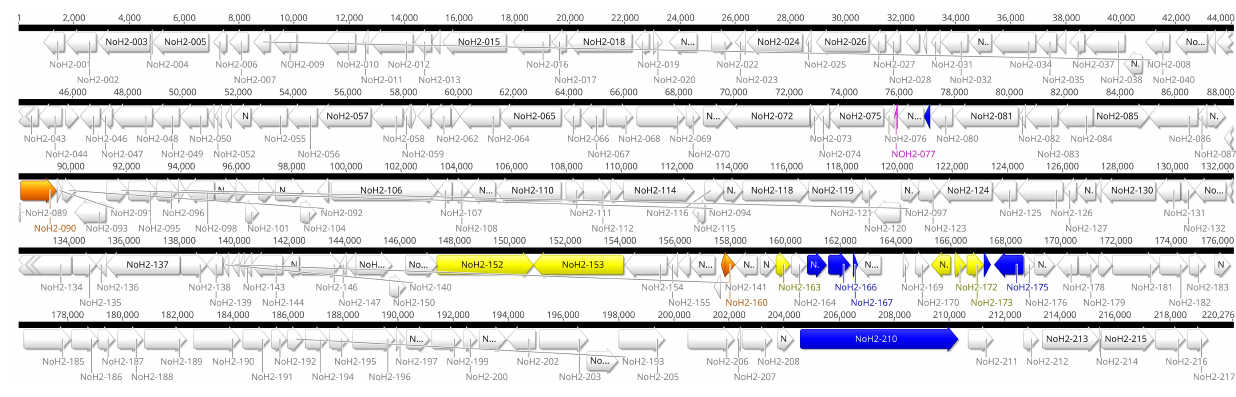
FIGURE 1 | Genome map of CPXV-No-H2. Localization of 217 predicted coding sequences (CDS) and nine putative recombination events in the CPXV-No-H2 genome. Green blocks represent the putative recombination events. Other colors were used to visualize the amino acid sequence similarity between translated CDS to other OPXV proteins: blue blocks represent CDS with a higher similarity to Alaskapox virus proteins, yellow blocks represent CDS with a higher similarity to Ectromelia virus (ECTV) proteins, orange blocks represent CDS with a higher similarity to Vaccinia virus (VACV) proteins, and fuchsia block represents the CDS with a higher similarity to ECTV, VACV, and Horsepox virus